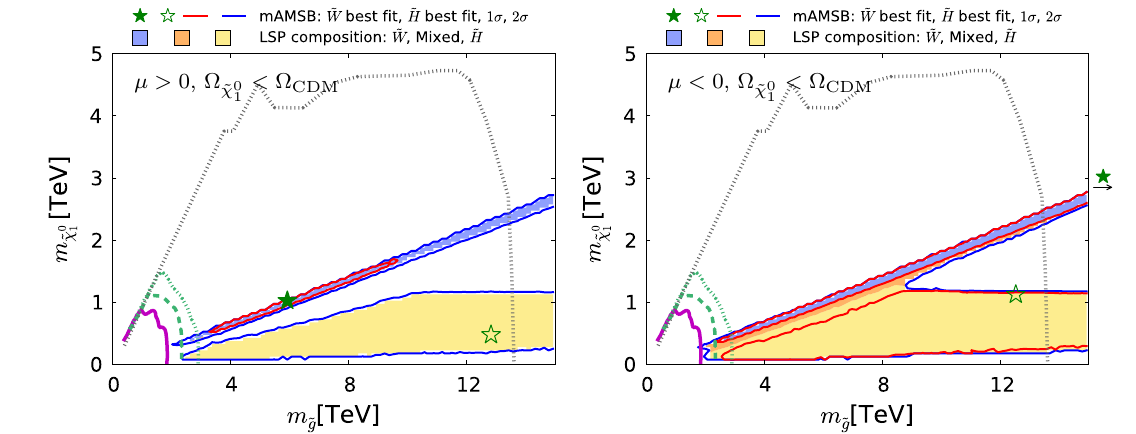
) plane allowed in the (cid:4) ≤ integrated luminosities of 300 and 3000 f b − 1 , respectively. The grey Fig. 23 The region of the ( m ˜ g , m ˜ χ 0 ˜ χ 0 1 1 μ > 0 ( left ) and μ < 0 ( right ). The purple solid line (cid:4) dotted line is the 95% CL sensitivity expected at a 100 TeV pp collider CDM case for with a 3000 f b − 1 integrated luminosity obtained from [142]. All con- represents the ATLAS 13-TeV 95% CL exclusion with the data with tours assume a simplified model with 100% BR for ˜ g → qq ˜ χ 0 13 f b − 1 [139]. The green dashed and dotted lines show the projected shadings are the same as in Fig. 4 95% CL sensitivity estimated by ATLAS [141] for 14-TeV data with